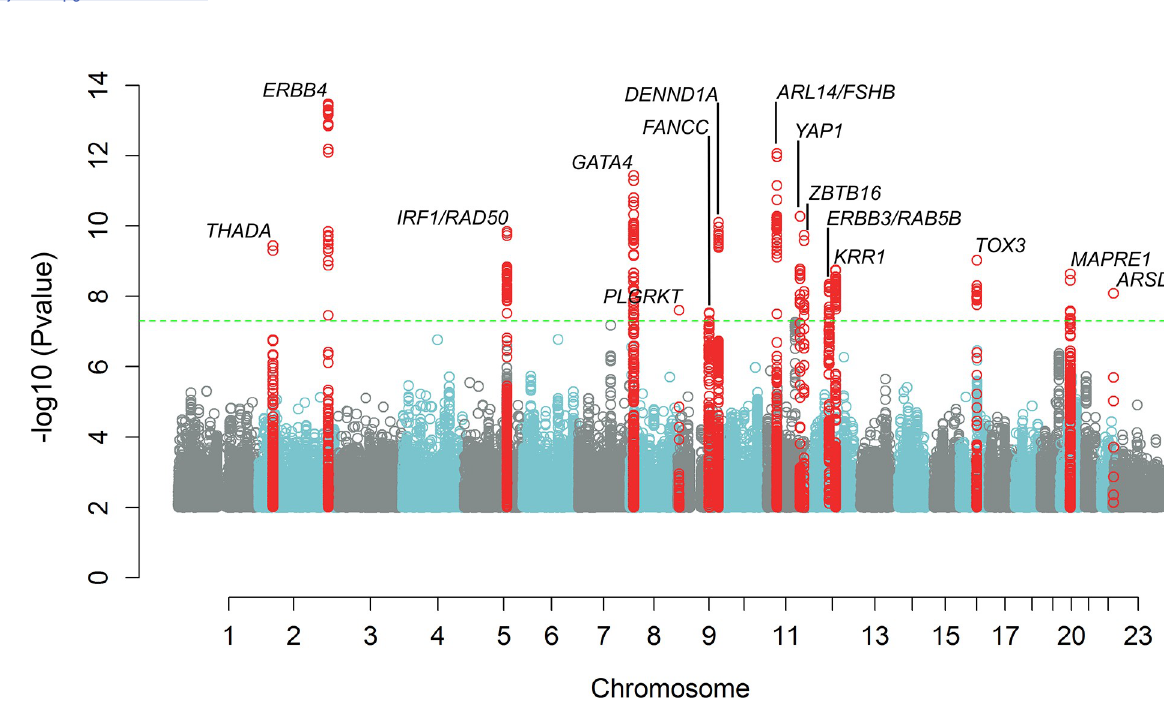
Fig 1. Manhattan plot showing results of meta-analysis for PCOS status, adjusting for age. The inverse log10 of the p value (-log10( p )) is plotted on the Y axis. The green dashed line designates the minimum p value for genome-wide significance ( < 5.0 x 10 − 8 ). Genome wide significant loci are denoted with a label showing the nearest gene to the index SNP at each locus. SNPs with p values � 1.0x10 -2 are not depicted.